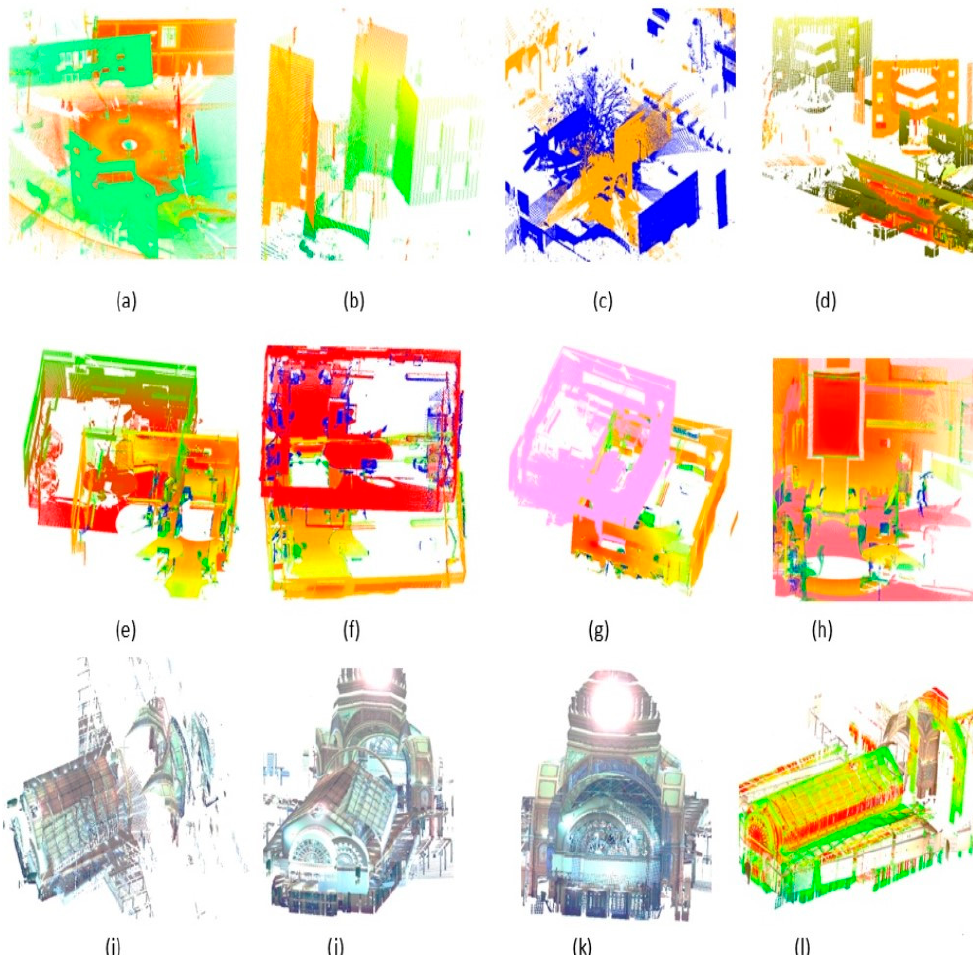
Figure 2. Detailed views of unregistered point clouds. ( a – d ) “Patio Batel” dataset, ( e – h ) “Lape” dataset and ( i – l ) “Royal exhibition building” dataset.